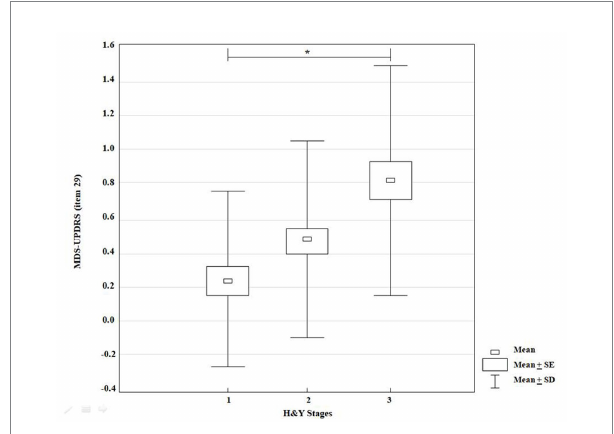
FIGURE 2 KW-ANOVA demonstrating differences in the MDS-UPDRS score (item 29) between groups 1 and